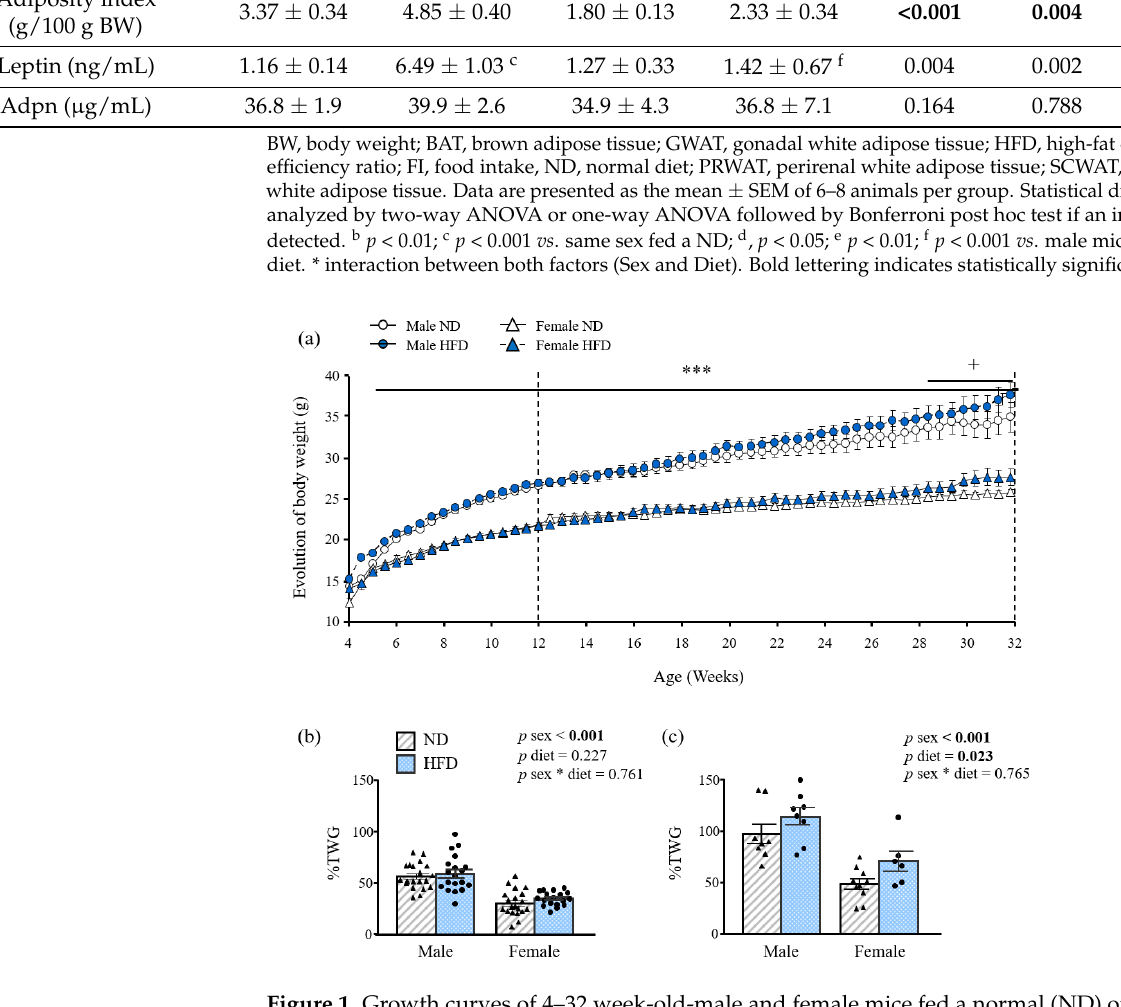
Figure 1. Growth curves of 4 – 32 week-old-male and female mice fed a normal (ND) or an high- fat diet (HFD) ( a ). Bar graphs show the % total weight gain (TWG) of ( b ) 12- and ( c ) 32- week-old mice ( n = 10 – 20). Data are the mean ± SEM. Statistical differences were analyzed by two-way ANOVA. * interaction between both factors (sex and diet); *** p < 0.001 effect of sex; + p < 0.05 effect of diet. p values lower than 0.05 are highlighted with bold text.